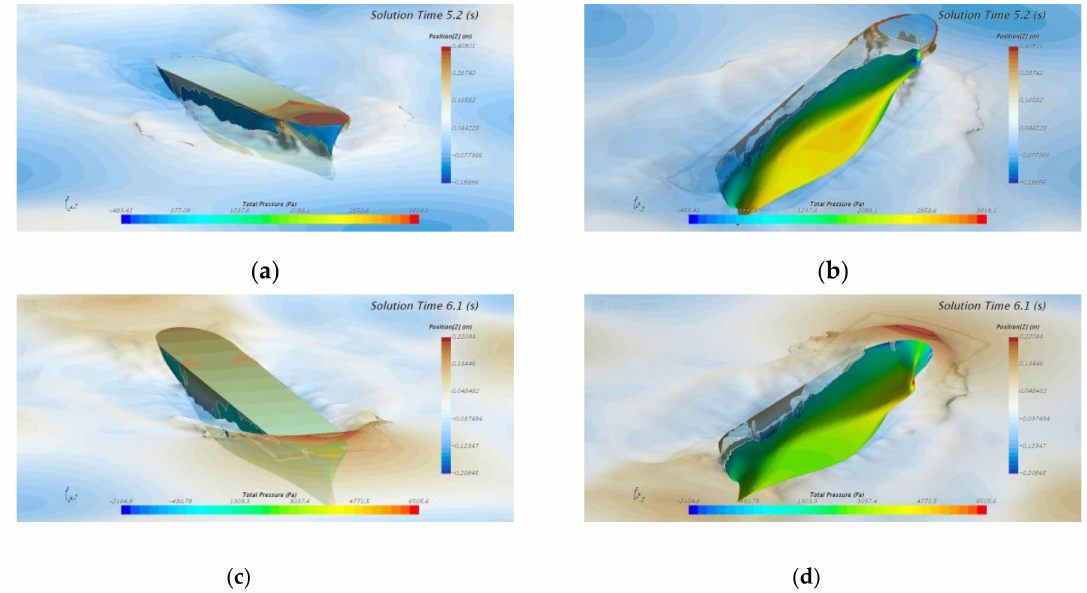
Figure 25. Starboard side view of wave impact and green water on deck ( λ / L = 1.2): ( a ) top view ( t = 5.2 s); ( b ) bottom view ( t = 5.2 s); ( c ) top view ( t = 6.1 s); ( d ) bottom view ( t = 6.1